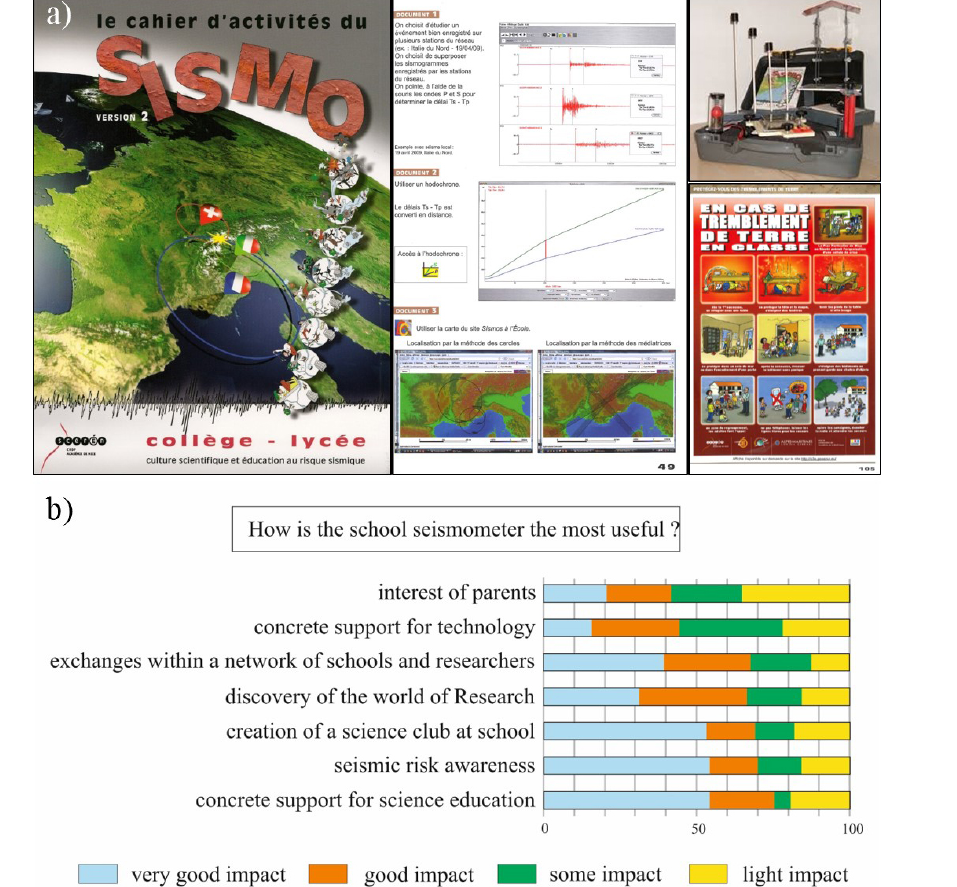
Figure 2. Pedagogical resources produced by the French educational network. (a) The seismo exercise book and the seismo box used to illustrate many aspects of the seismic phenomenon. (b) Focus on teachers’ answers to the survey. In this case, the graph shows the impact of the installation of a seismometer at a school relative to different